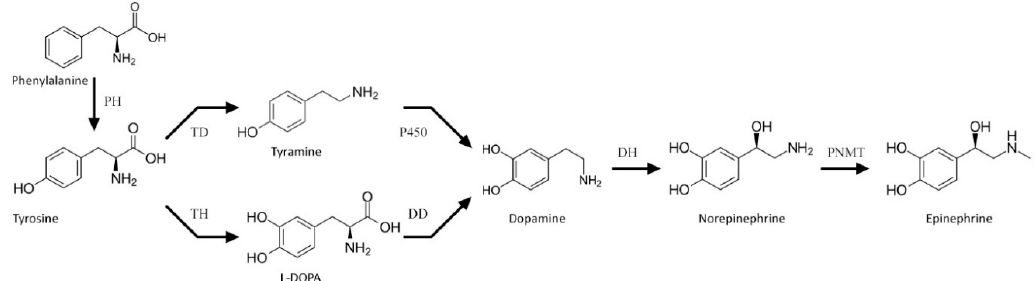
Figure 1. Scheme of the catecholamine biosynthesis pathway. PH—phenylalanine hydroxylase, TH—tyrosine hydroxylase, TD—tyrosine decarboxylase, DD— L -DOPA decarboxylase, DH—dopamine β -monooxygenase, and PMNT—phenylethanolamine N -methyltransferase.